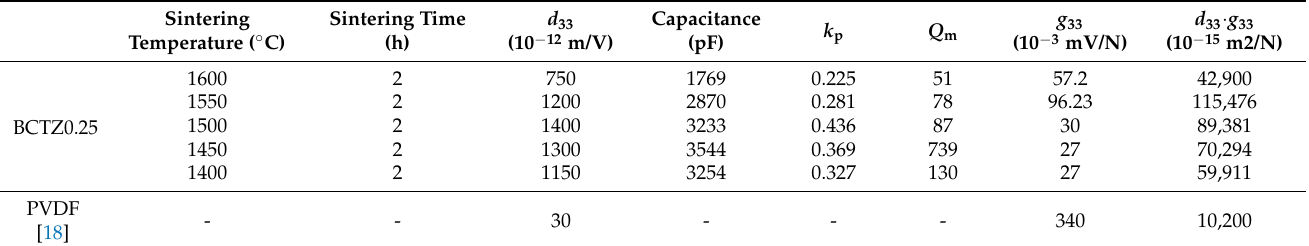
Table 1. Piezoelectric and dielectric properties of BCTZC0.25 samples and PVDF.